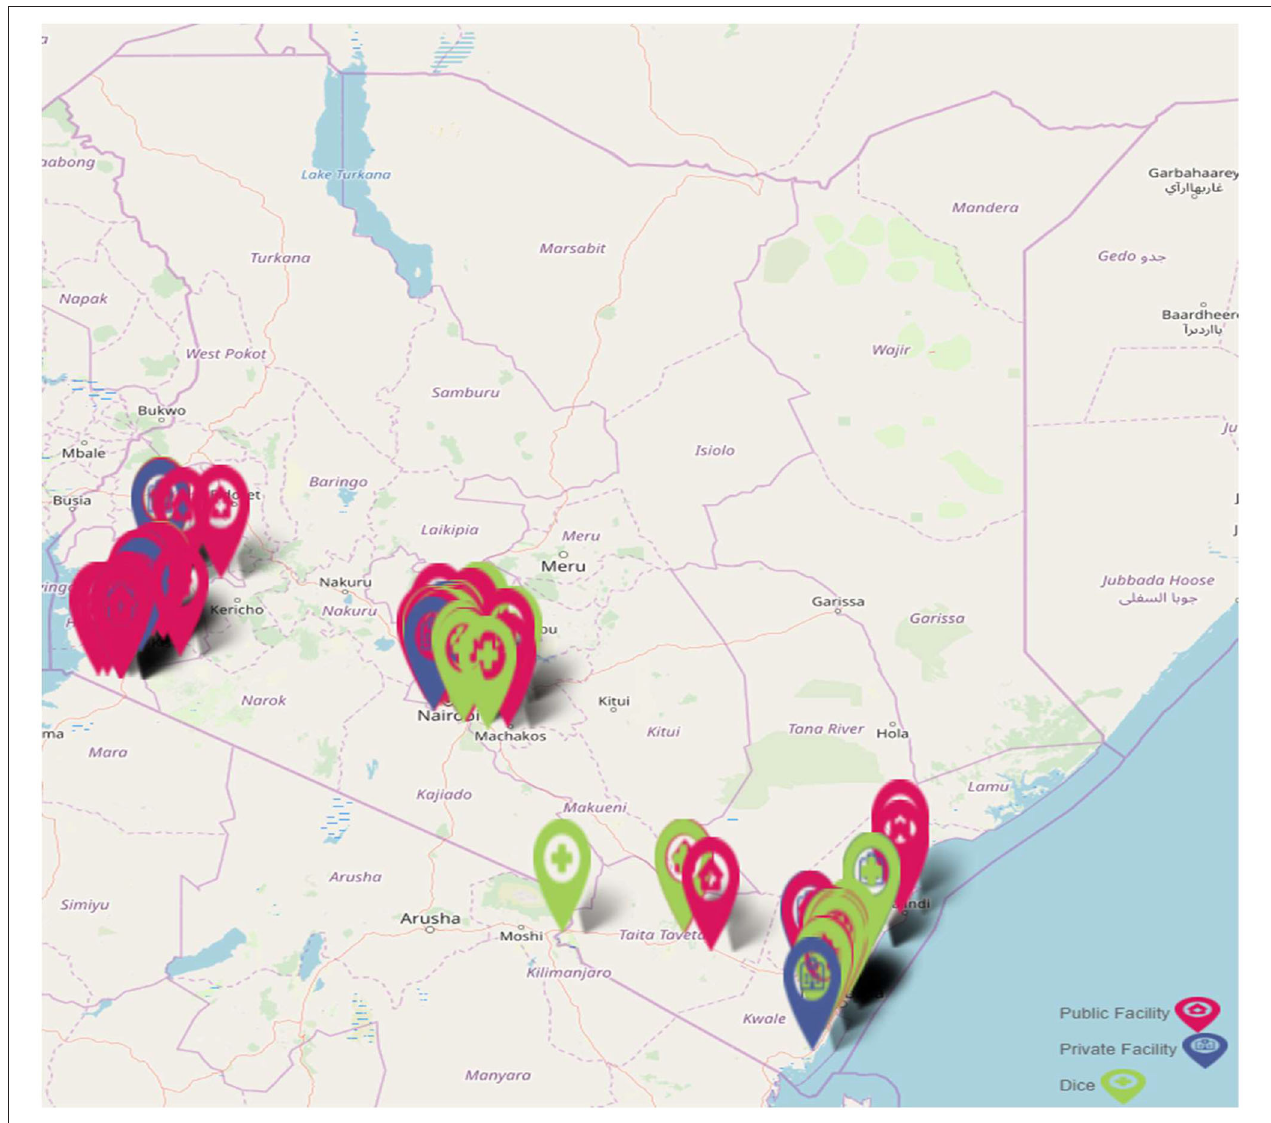
FIGURE 1 | Jilinde project implementation